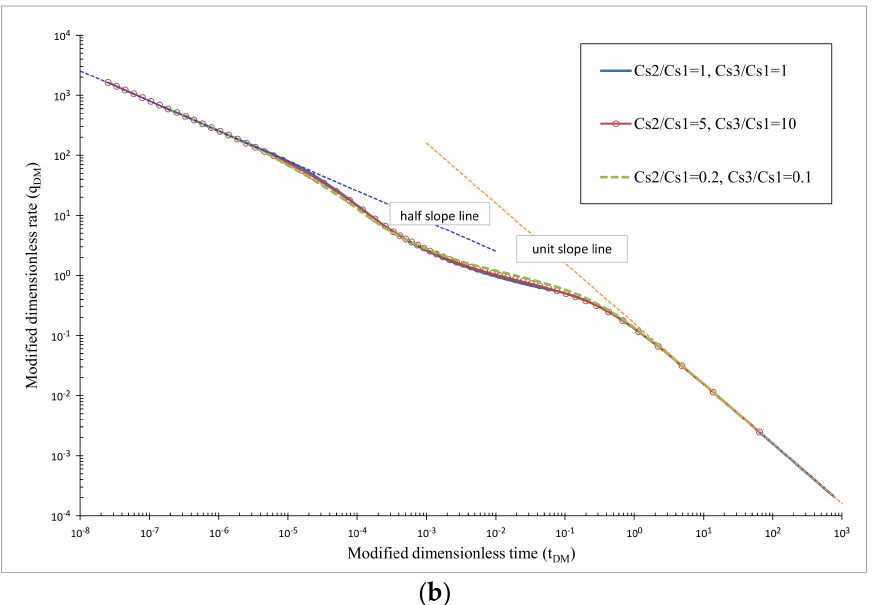
Figure 15. ( a ) Dimensionless production rate q wD vs. material balance time t MBD and ( b ) modified dimensionless production rate q DM vs. modified dimensionless time t DM , under various storativity ratio among layers, with 2 y e 1 D = y e 2 D = 100, h e 1 D = h e 3 D = 47.5, h e 2 D = 5, and M 2 / M 1 = 1, M 3 / M 2 =